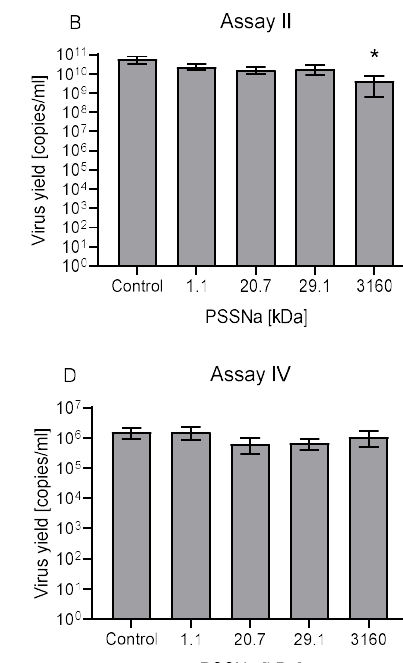
Figure 4. Inhibition of different strains of ZIKV replication cycle by PSSNa. U251 cells were infected with the virus in the presence of different polymers for four days. Inhibition of the infection was evaluated using RT-qPCR. Data are shown as virus yield (copies of viral genome per milliliter). The results are presented as average values of at least three replications.